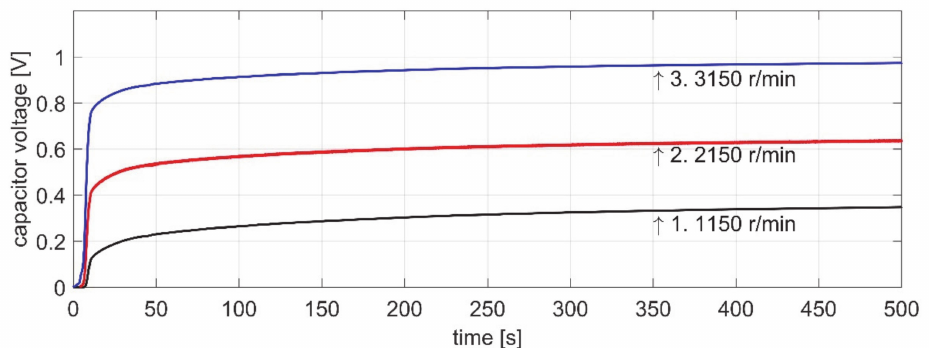
Figure 13. Voltages for three given rotor speeds, d = 24 mm.